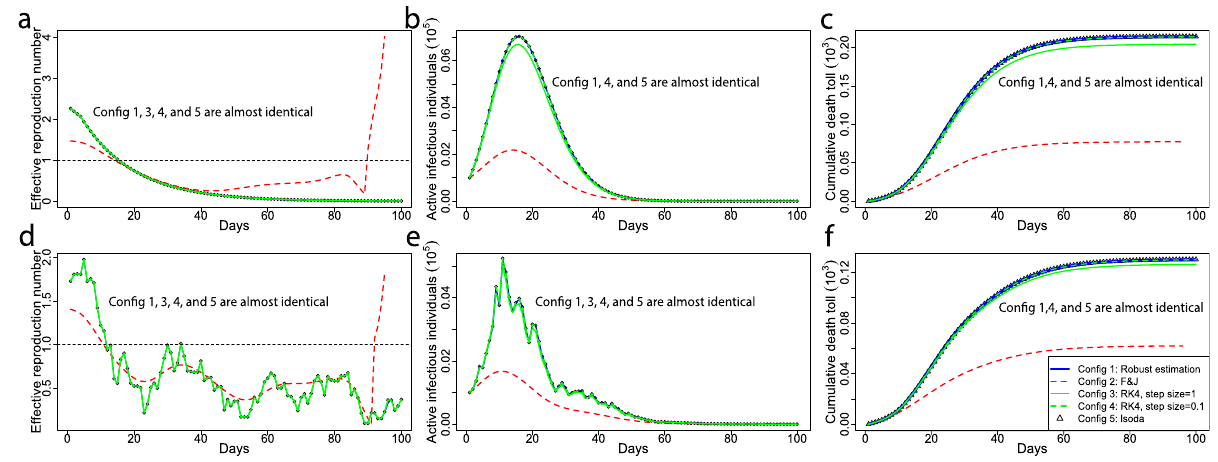
Figure 6. ( a – c ) Simulated comparison with noise-free observations. The black circles are the solution of the ODEs of the SIRDC model via the default numerical solver Isoda in the function ode in deSolve R package. The green solid and dash curves are the numerical solutions from Runge–Kutta method with the 4th order integration and step size being 1 and 0.1, respectively. The Blue solid curves are the robust estimation from algorithm 1 and red dash curves are the estimation in 9 . In the simulation with noise-free observations, we let time duration be T = 100 days, the population size N = 10 7 , the initial values of 5 compartments chosen as ( S ( 1 ) , I ( 1 ) , R ( 1 ) , D ( 1 ) , C ( 1 )) = ( N − 2000, 1000, 1000, 0, 0 ) and the transmission rate − 0.7 ( 9 β( t ) = exp ( t − 1 ) + 1 ) , for 1 ≤ t ≤ T . ( d – f ) results of the simulation with noisy observations, T − 1 which have the same interpretation as ( a – c ). In this simulation, we set the transmission rate (cid:31) (cid:30) − 0.7 ( 9 + ǫ , for 1 ≤ t ≤ T and ǫ ∼ N ( 0, 0.04 ) , and the other parameters are held β( t ) = exp ( t − 1 ) + 1 ) T − 1 the same as in the noise-free simulation. The transmission rates estimated from the method F & J are truncated (cid:31) (cid:30) to be within [0,10]. The solution from our robust estimation approach, the Isoda and the Runge–Kutta method with the 4th order and step size being 0.1 overlap for both scenarios.